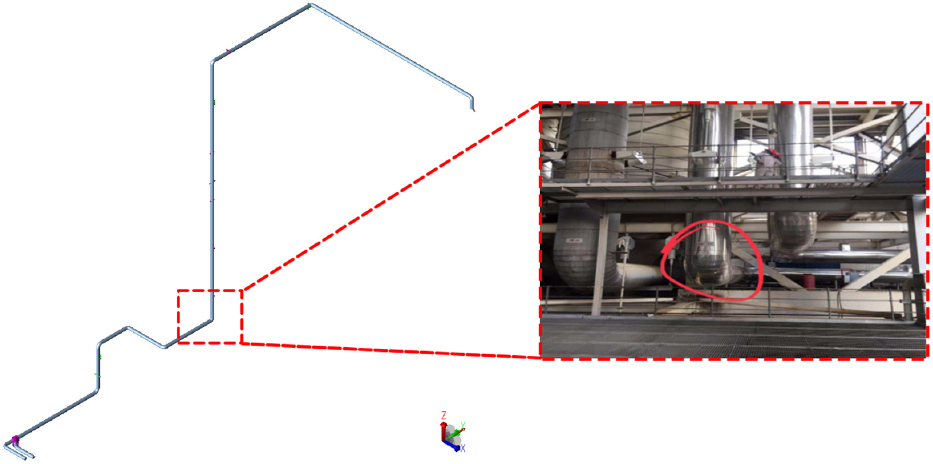
Figure 1. Schematic of the main steam pipeline system of an ultra-supercritical